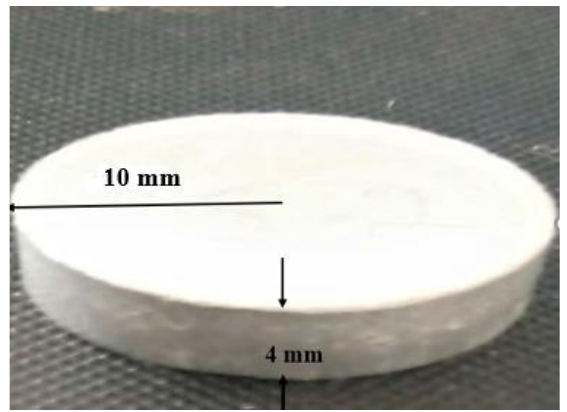
Figure 1. Sample pallets.